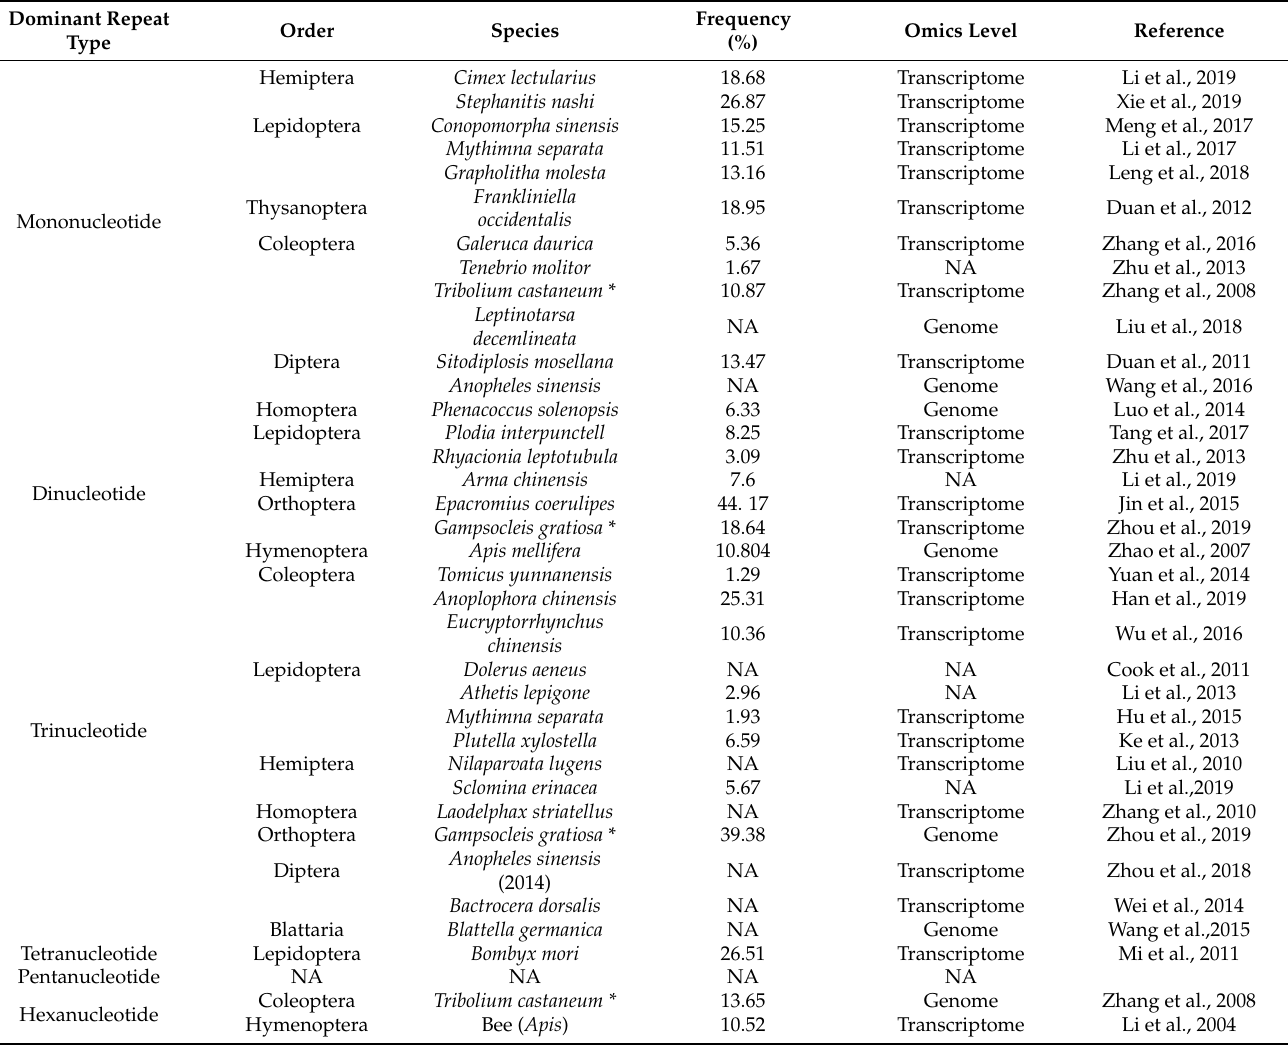
Table 7. Dominant repeat types in different insects (incomplete